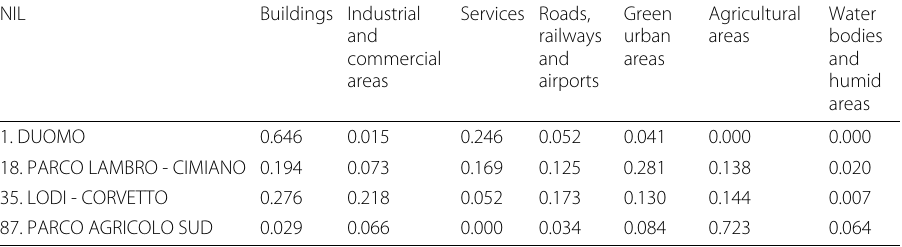
Table 1 Land-use mixes of NILs 1, 18, 35 and 87, selected here as representative of Communities 1, 2, 3 and 4 respectively shown in Fig. 3, which have been identified by community detection performed on land uses NIL Buildings Industrial